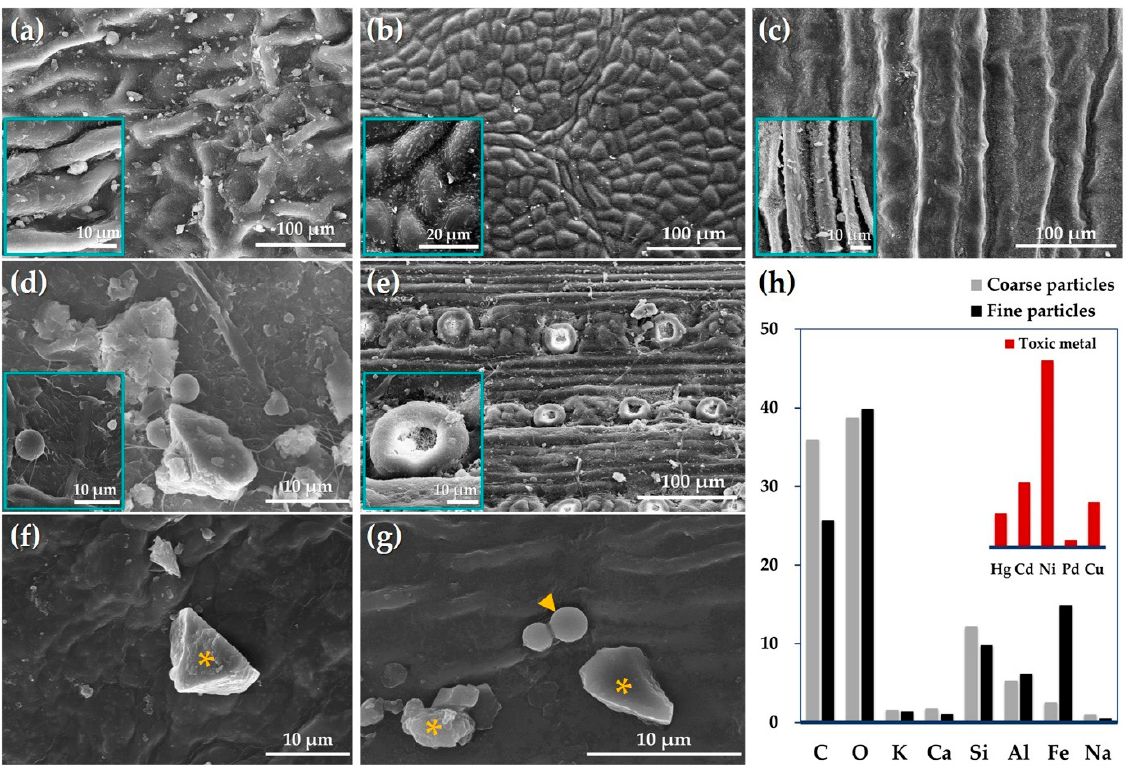
Figure 6. Comparative analysis of scanning electron microscopy with energy dispersive X-ray spectroscopy (SEM-EDS) on adaxial leaf surfaces. ( a ) P. yedoensis (roughened stripe-like grooves and non-glandular trichomes on both adaxial and abaxial surfaces), ( b ) Q. acutissima (adaxial surfaces with bullate-like grooves and abaxial surfaces with simple uniseriate and stellate trichomes), ( c ) M. glyptostroboides (waxes on adaxial surfaces), ( d ) E. japonicus (smooth adaxial surfaces with thick wax layers and adaxial leaf surfaces with concave stomata), ( e ) P. densiflora (elliptical-rounded stomata on both adaxial and abaxial needle surfaces), ( f , g ) size-segregated PM particles (e.g., asterisk and arrow) on leaf surfaces used for elemental composition test, and ( h ) SEM-EDS elemental analysis. Note: Images show different surface roughness configurations of grooves, stomata, and particles.